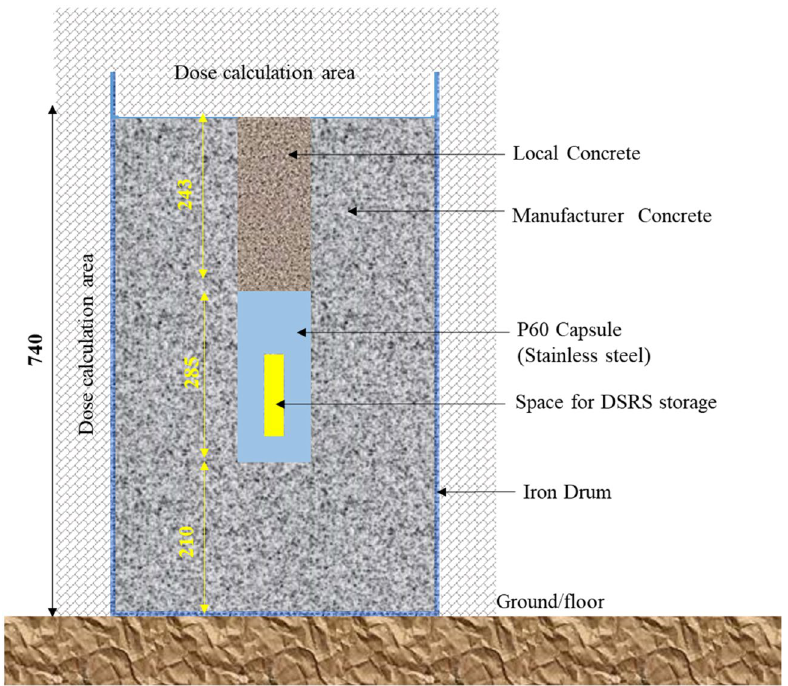
Figure 2. Geometry of the simulation designed for DSRSs waste management optimization. The effective dose calculation area is set on the r-axis (refer to as the x-axis or horizontal axis) and z-axis (refer to as the vertical axis in the remaining part of the